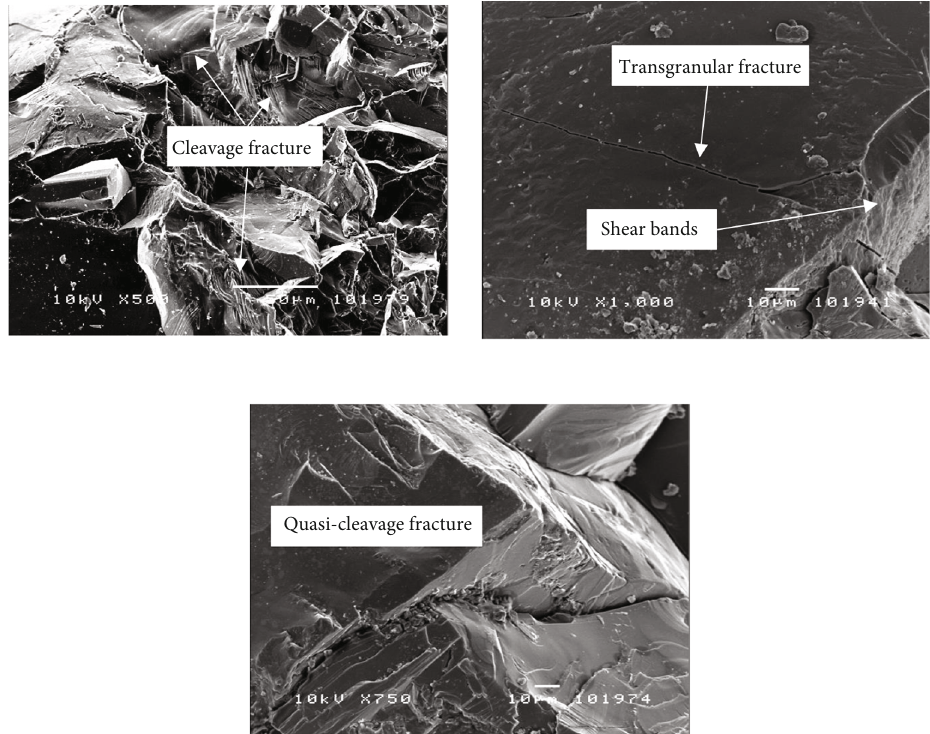
Figure 12: Local fracture morphology of frozen granite from -20 ° C to -40 °